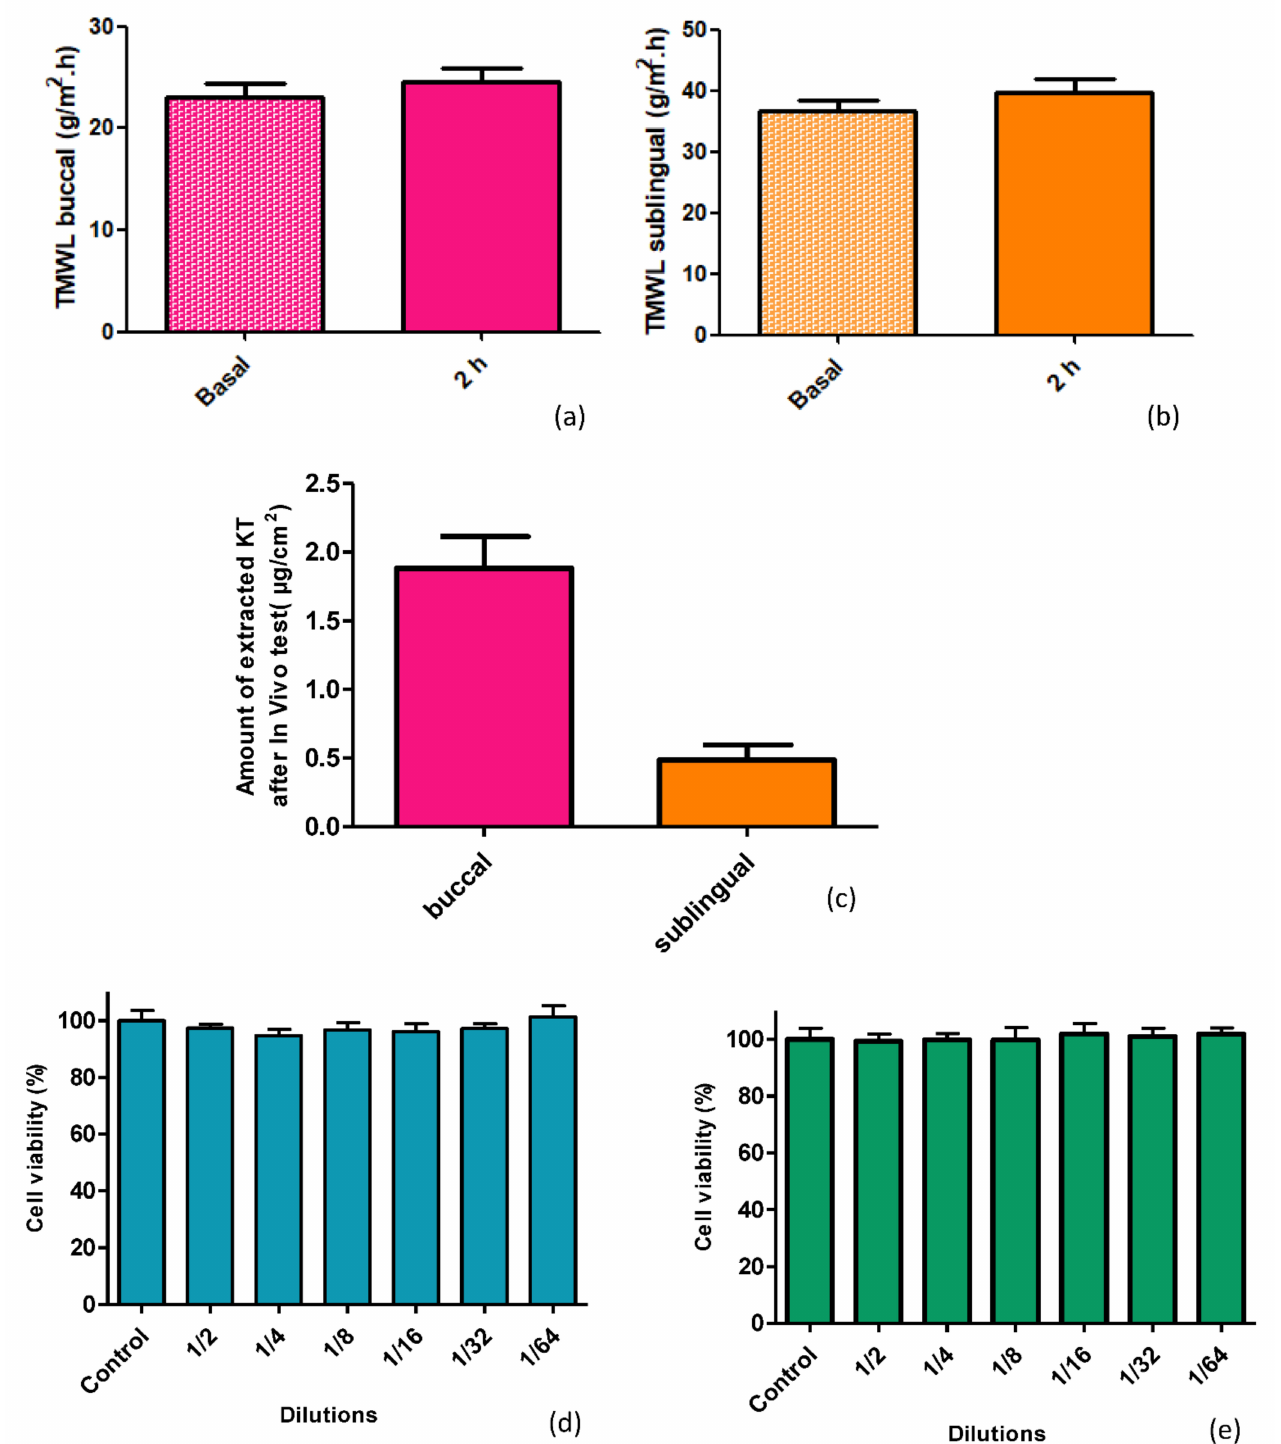
Figure 6. In vivo studies: Integrity of the buccal ( a ) and sublingual ( b ) mucosae. TMWL values taken before the alginate-HA 2% KT gel application (basal) and 2 h after application. ( c ) Amount of extracted KT ( µ g/cm 2 ) from the mucosae after in vivo test on pigs. Results represented as mean and SD (n = 3). ( d , e ) Cell viability (%) after the MTT test for different dilutions of the 2% KT alginate-HA gel and the KT-solution, respectively. Control: untreated cells in their environment. Results expressed as mean and SD (n =